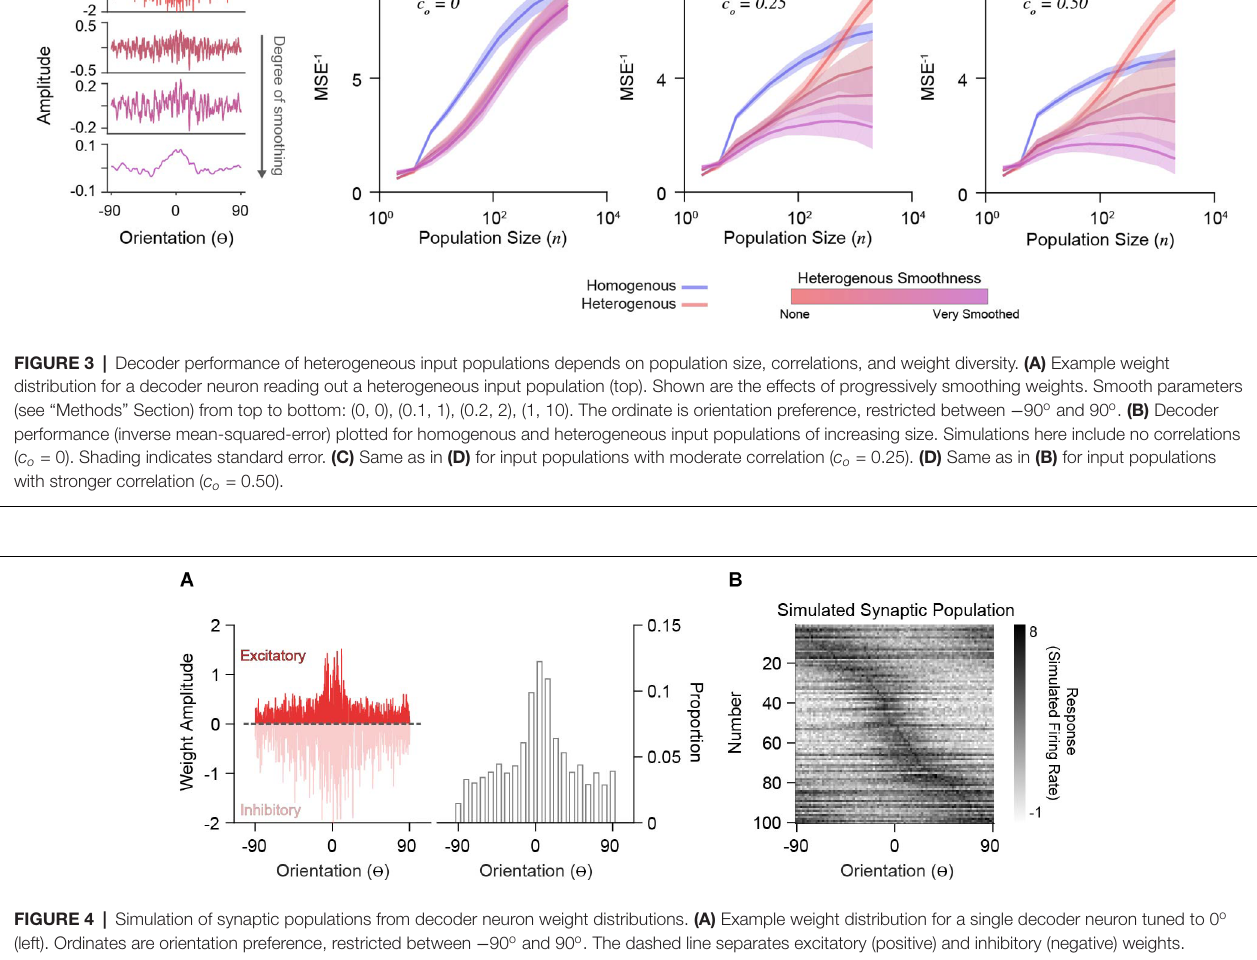
Figure 5C ). Tuning correlation between all imaged dendritic spines and soma was low (median r cell = 0.31, n = 7,151